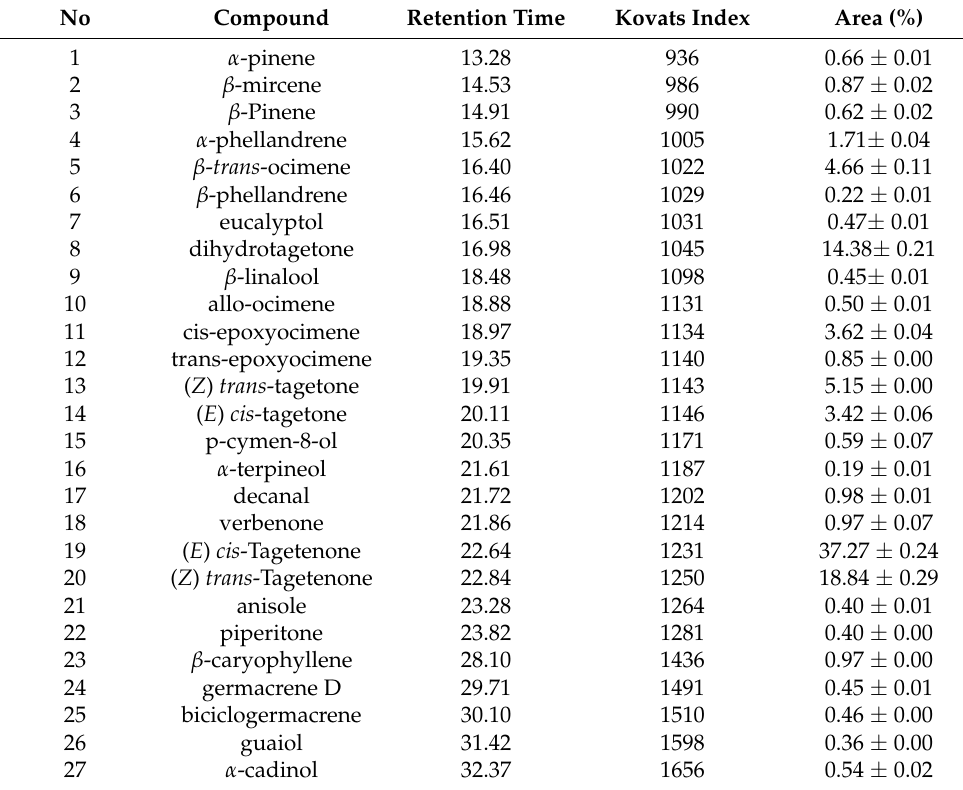
Table 1. Chemical composition of T. elliptica essential oil obtained from leaves.